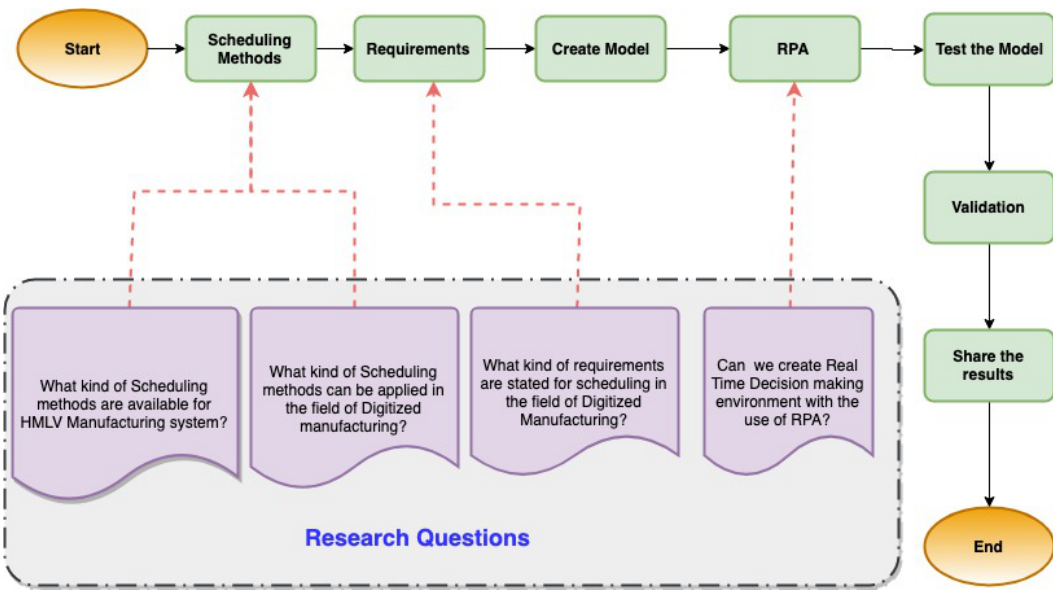
Figure 2. Positions of research questions towards research-paper